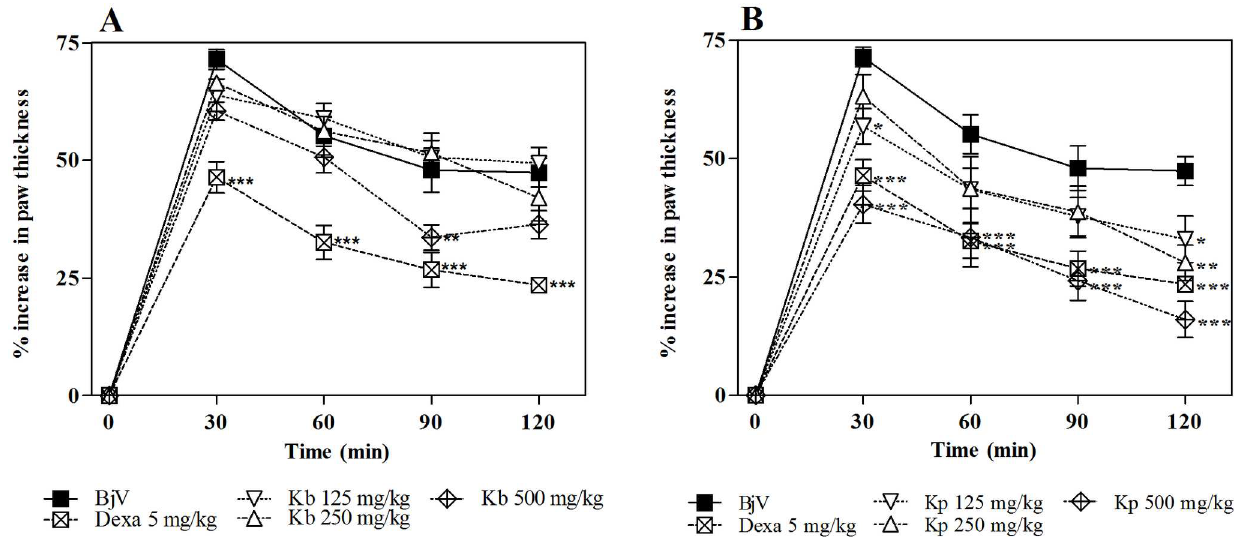
Fig 6. Inhibition of the edematogenic activity of B . jararaca venom (BjV) by extractsof K . Brasiliensis (Kb) (A) and K . pinnata (Kp) (B) in pre-treatment protocol. BjV was injectedi.pl. in the right hind paw of mice pre-treatedi.p. with different extracts. Paw thickness was measuredduring120 min after venom injection. Edema was expressedas the increasein paw thickness calculatedas the percentage difference betweenthe paw thickness after (at respective time) and before (basal values)venom injection.The points represent the mean ± SEM (n = 5). * p < 0.05, ** p < 0.01and *** p < 0.001comparedto the group receivingvenom alone along with the i.p. injectionof 5% castor oil in PBS (Two-way ANOVA followedby the Bonferroni